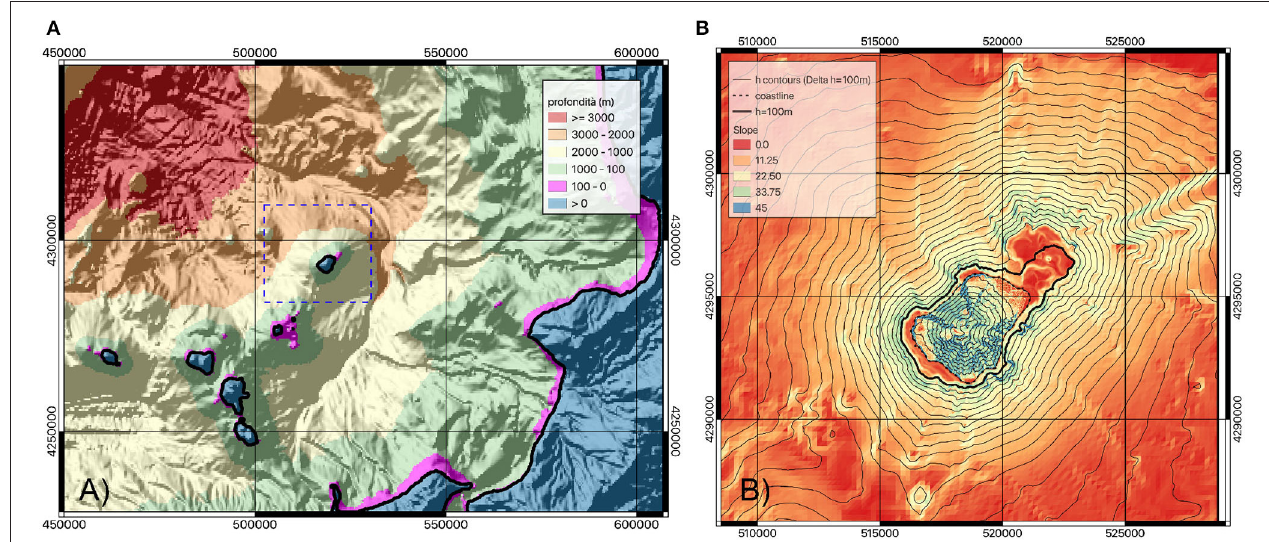
FIGURE 1 | (A) Topo-bathymetry of the Southern Tyrrhenian sea, with the Aeolian archipelago and the island of Stromboli (dashed inset frame). (B) Map of proximal topographic and bathymetric slopes of the Stromboli